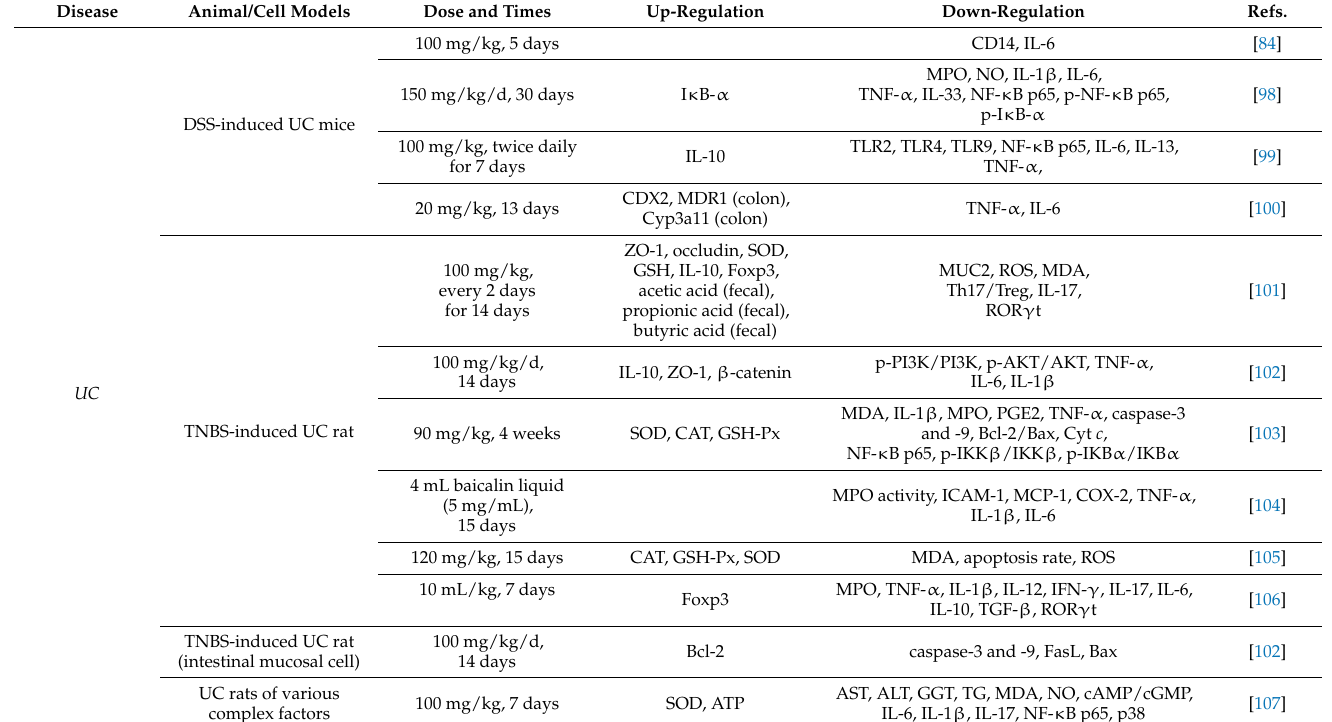
Table 1. The effect of baicalin on inflammatory bowel disease and colorectal cancer. Disease Animal/Cell Models Dose and Times Up-Regulation Down-Regulation Refs.